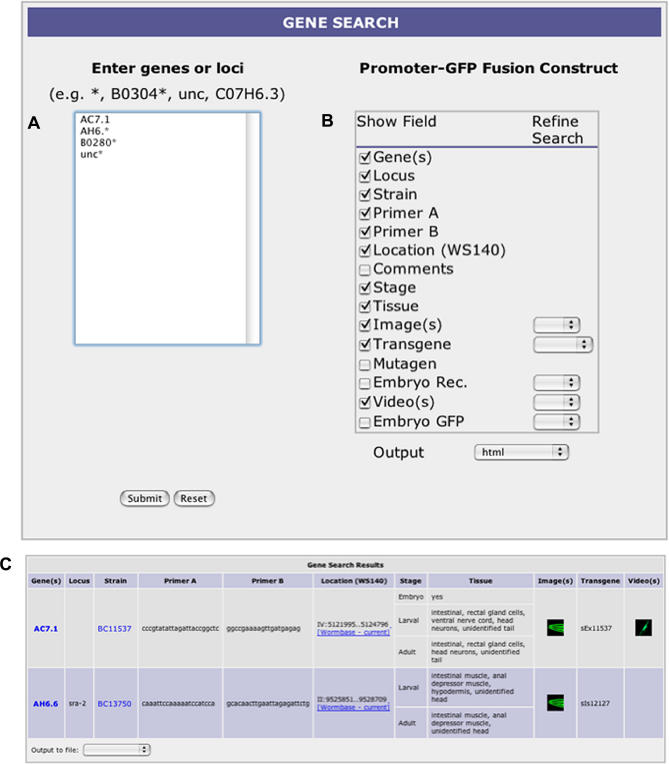
The Gene Search Page and Search ResultsThe Search page (A) and (B) allows the user to search the dataset with a combination of gene names and data types. The user can enter (A) specific gene names or use an asterisk (*) to represent all genes and then choose (B) the list of data types representing specific information about the gene(s) of interest. The logic for the Field column is OR, and the results (C) will display columns for the data types. The Refine Search column (B) operates under AND logic for the selected field, and OR logic between fields, e.g., selecting “stable” transgene and “yes” Images will output all genes that are either stable or have an associated image. Thus the genes displayed are limited only to those that evaluate to True for a selected field.